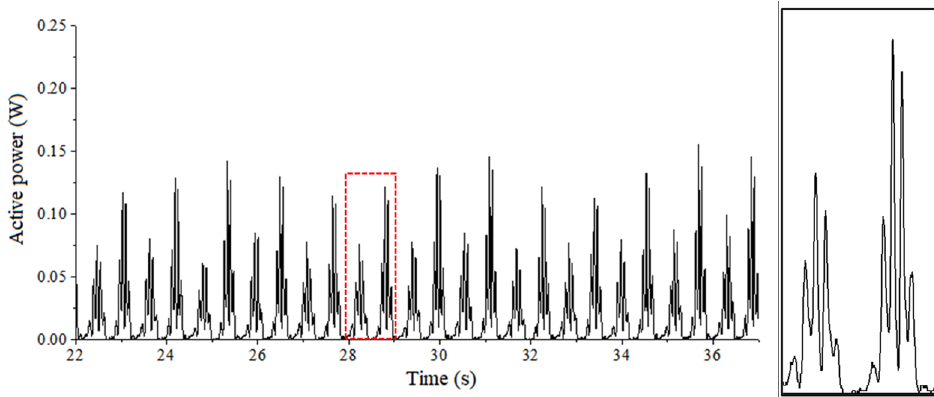
Figure 21. Active power diagram (including the zoom-up of the enclosed region between 28.6 s and 29.8 s) under partial standing waves of T / T p = 1.0, h = 0.6 m.